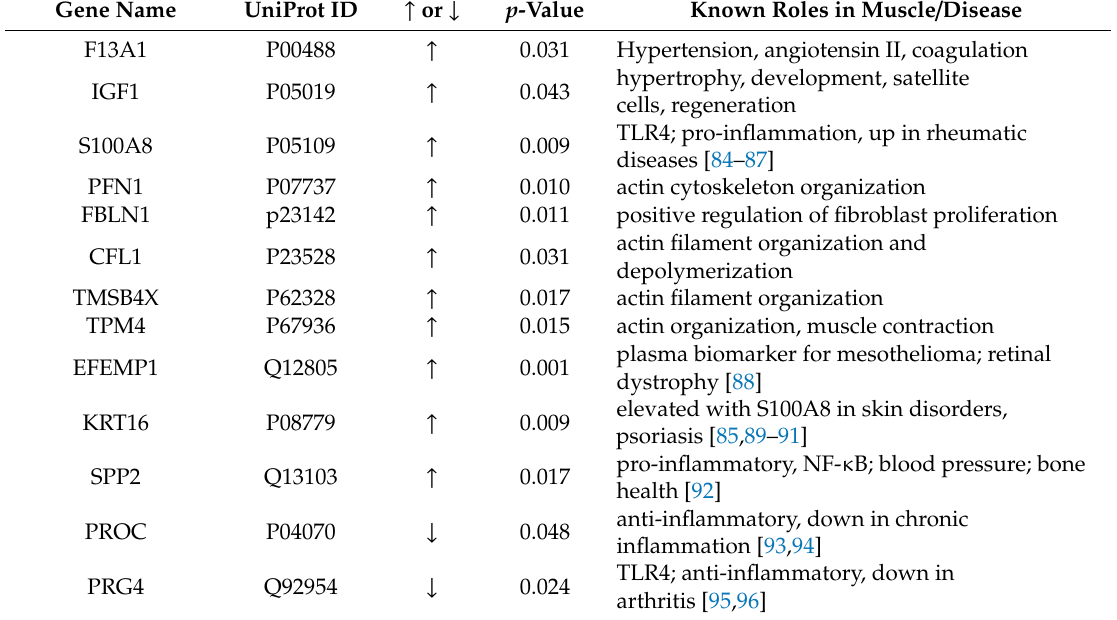
Table 4. Thirteen circulating proteins identified as dysregulated in FSHD plasma via LC-MS /